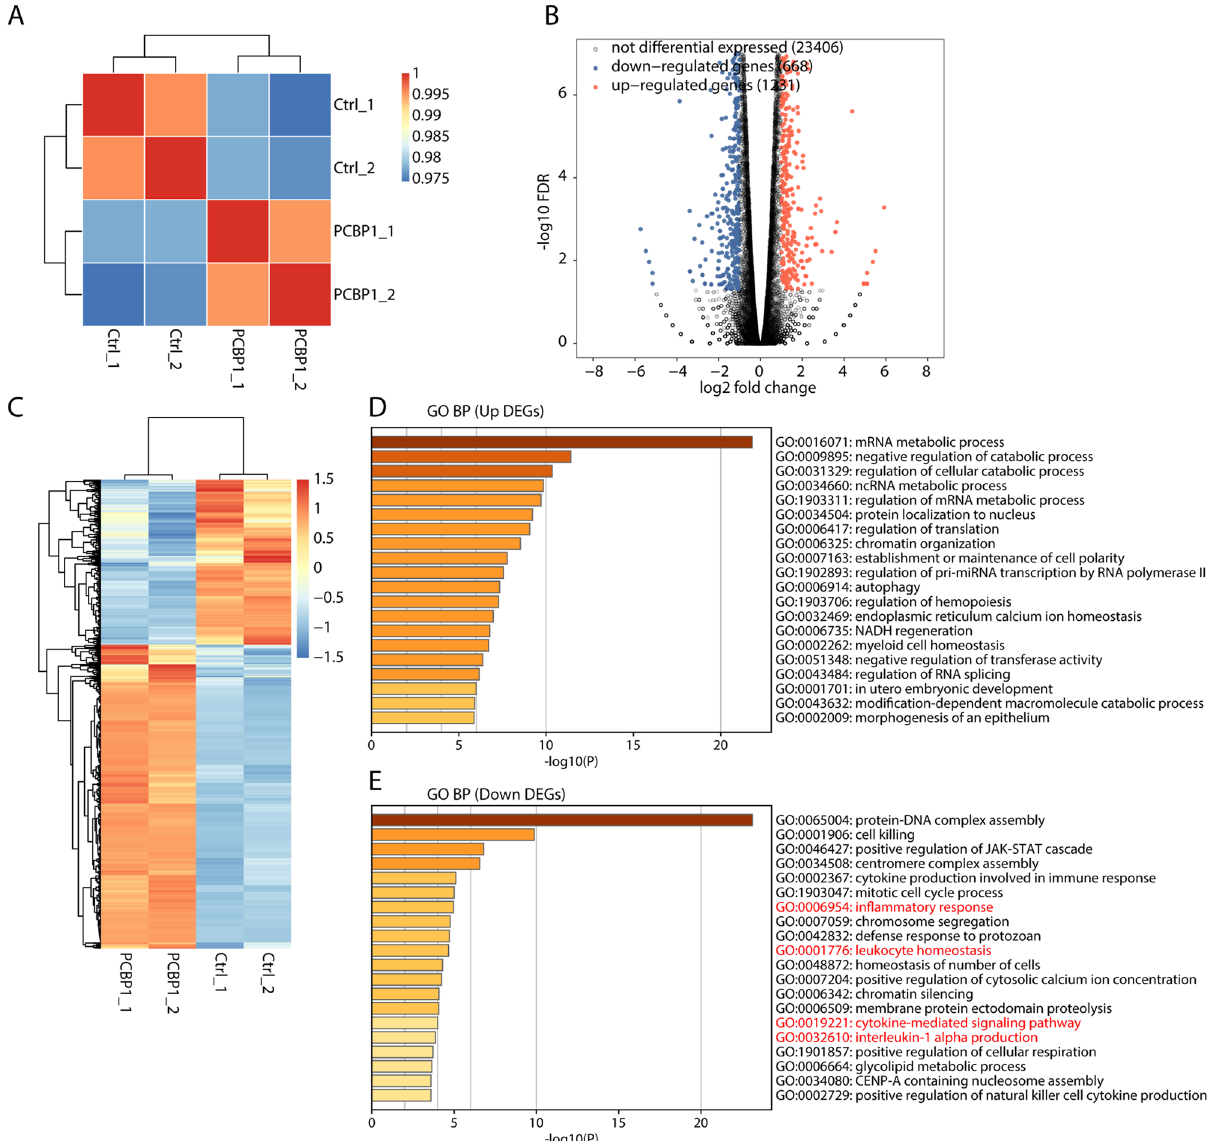
Figure 2. Transcriptome analysis of differentially expressed genes (DEGs) in Pcbp1 -knockdown Th1 cells and control Th1 cells. ( A ) Hierarchical clustering heat map showed correlation between Pcbp1 -knockdown and control samples based on FPKM value of all expression genes. ( B ) Volcano plot showed all DEGs between Pcbp1 -knockdown and control samples with edgeR. FDR < 0.05 and FC (fold change) ≥ 2 or ≤ 0.5. ( C ) Hierarchical clustering heat map showed expression levels of all DEGs. ( D ) Bar plot exhibited the most enriched GO biological process results of the up-regulated DEGs, that making use of analyses by Metascape. ( E ) Bar plot exhibited the most enriched GO biological process results of the down-regulated DEGs, that making use of analyses by